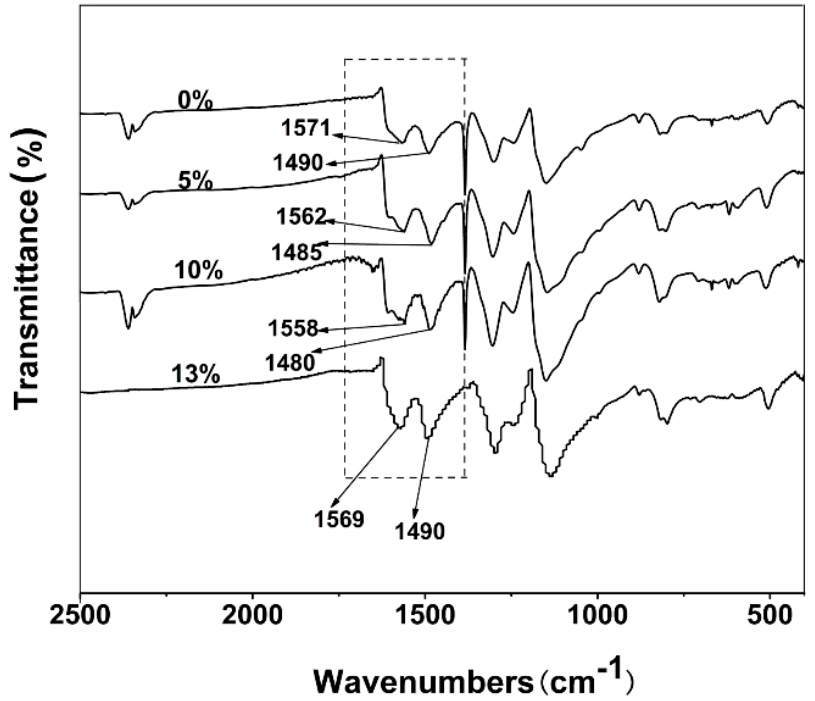
Figure 9. Effects of the amount of ASPB on the electrical conductivity of PANI/ASPB